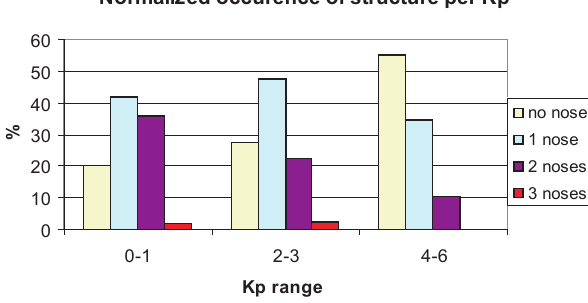
Fig. 4. Normalized occurrence of the number of structures per K p